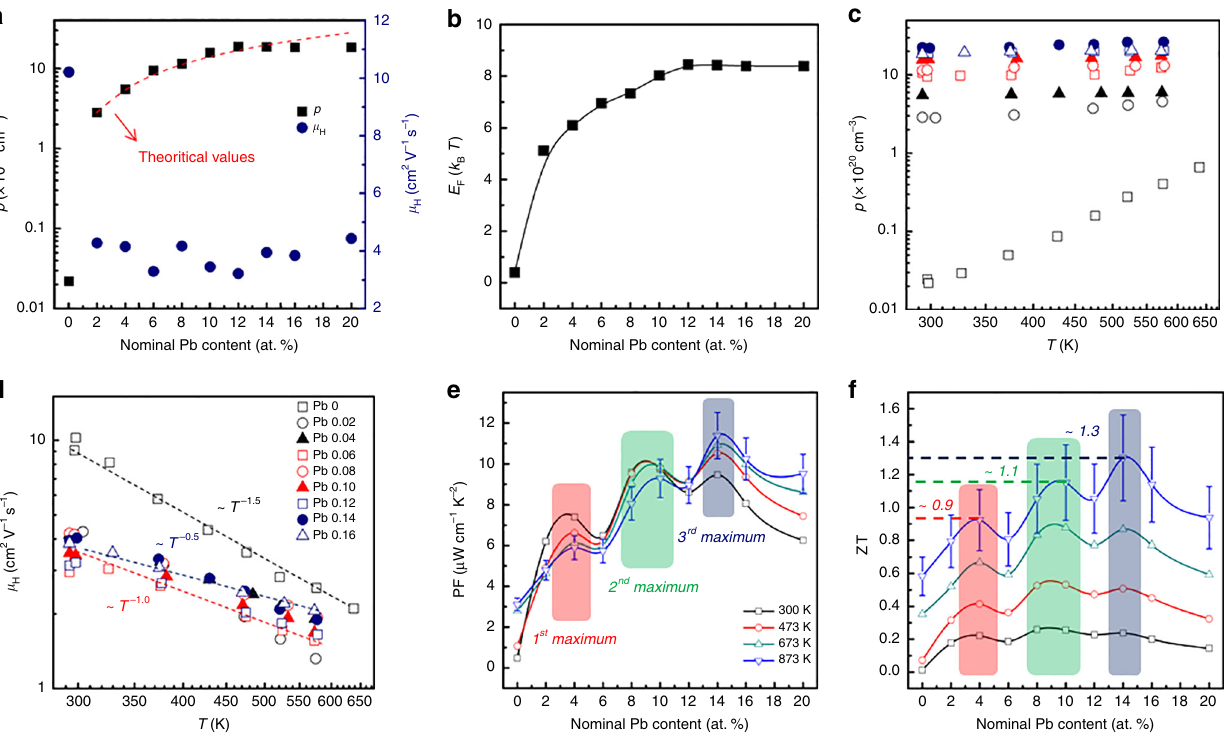
Fig. 2 Electrical transport properties of Bi 1 − x Pb x CuSeO ( x = 0 – 0.2). a Carrier concentration p and Hall mobility μ Η at room temperature. b Calculated Fermi energy ( E F ) based on experimental p and the calculated density of states (DOS). Temperature dependences of c p and d μ Η (300 – 650 K). e Power factor (PF) and f dimensionless fi gure of merit (ZT) as a function of the nominal Pb content. Three maxima are marked as shaded areas for PF and ZT. The uncertainties of the Seebeck coef fi cient and the electrical conductivity measurements are ~3% and ~5%, respectively, giving rise to a PF error of ~10%. Combined with ~10% uncertainty in the thermal conductivity measurement, the measurement error of ZT is estimated to be